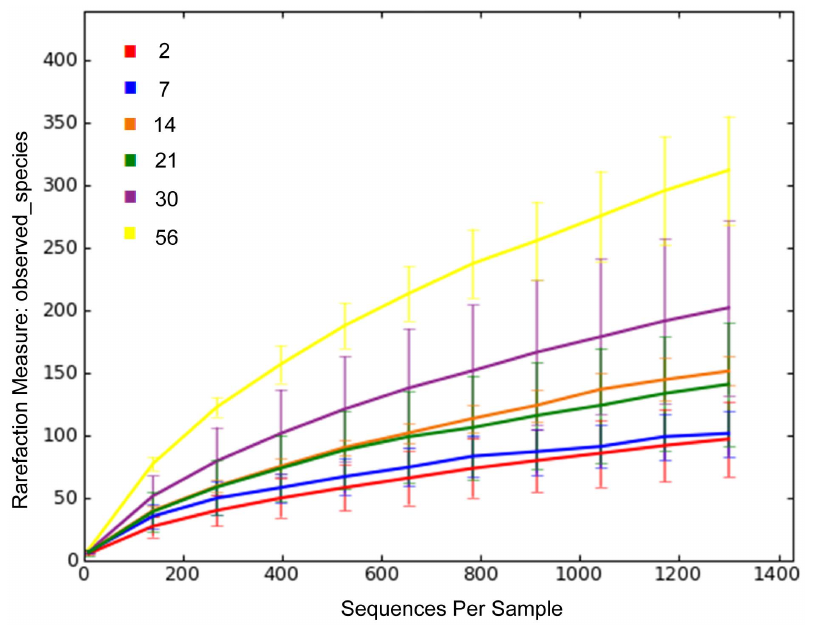
Figure 2. Rarefaction analysis of 16 S rRNA gene sequences obtained from fecal swabs from foals. Lines represent the average numbers obtained at each age (legend numbers refer to the age in days), while the error bars represent the standard deviations. The analysis was performed on a randomly selected subset of 1,300 sequences per sample and included samples from 42 foals. Note the progressive increase in observed species (representing microbial diversity) with sequential age. The numbers for the legend represent age (in